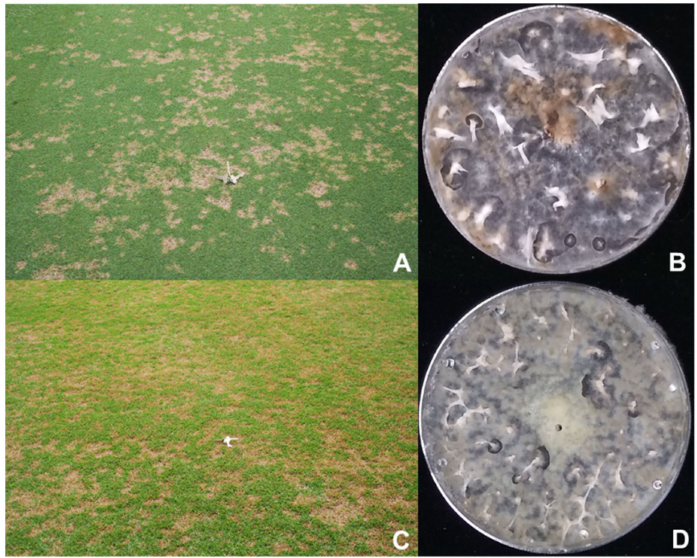
Figure 1. Signs and cultures of Clarireedia jacksonii and C. monteithiana . ( A ) Symptoms of dollar spot caused by C. jacksonii on Agrostis stolonifera (bentgrass). ( B ) Culture of C. jacksonii grown on potato dextrose agar (PDA) for 14 days. ( C ) Symptoms of dollar spot caused by C. monteithiana on Paspalum vaginatum (seashore paspalum). ( D ) Culture of C. monteithiana grown on potato dextrose agar (PDA) for 14